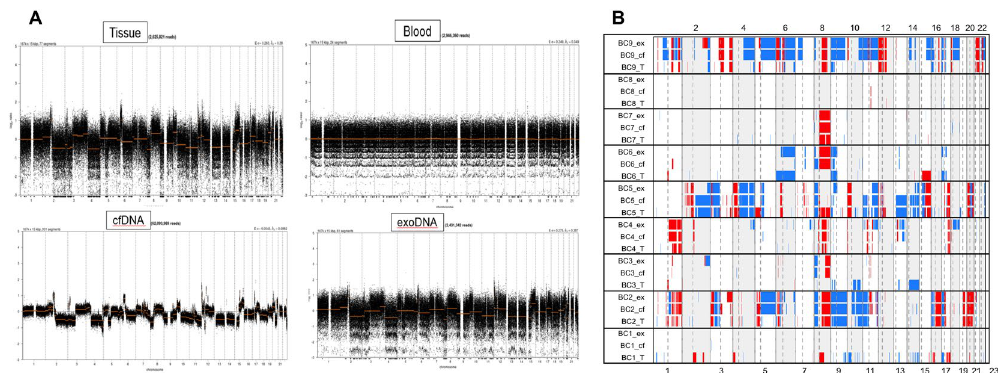
Figure 3. CNV profiles of patients 5 (A) and copy number aberration plot of 9 patients with bladder cancer. Cell free DNA and exosomal DNA samples present similar pattern of copy number aberration with tumor